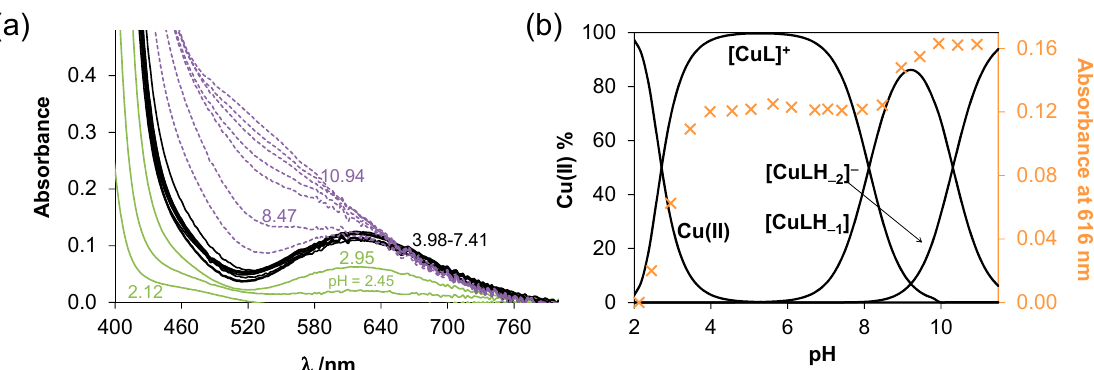
Figure 4. ( a ) UV-vis absorption spectra recorded for the Cu(II)—Pro-SISC-Me (1:1) system at various pH values; ( b ) Concentration distribution curves calculated under the same conditions with absorbance values measured at 616 nm (×). ( c ligand = c Cu(II) = 1.0 mM; 30% ( v / v ) DMSO/H 2 O; T = 25 °C; I = 0.10 M (KCl); ℓ = 2 cm).